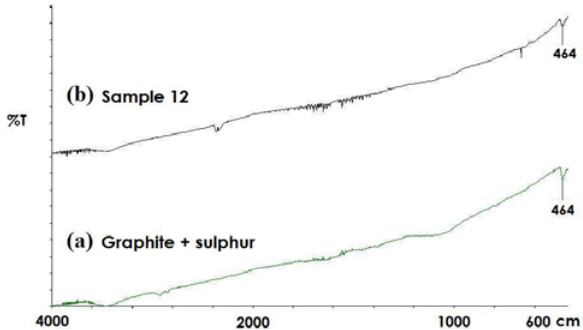
Figure 4. FT-IR spectrum of a graphite/sulphur mixture (a) com- pared with that of sample12 Product H (b).